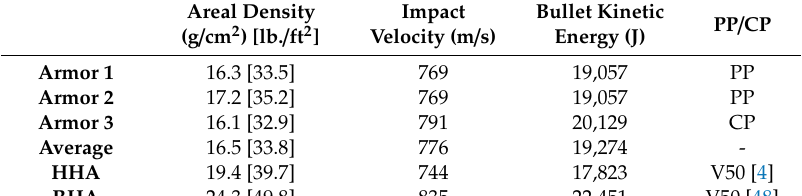
Table 2. Summary of ballistic testing of CMF armors against the 14.5 × 114 mm B32 round.